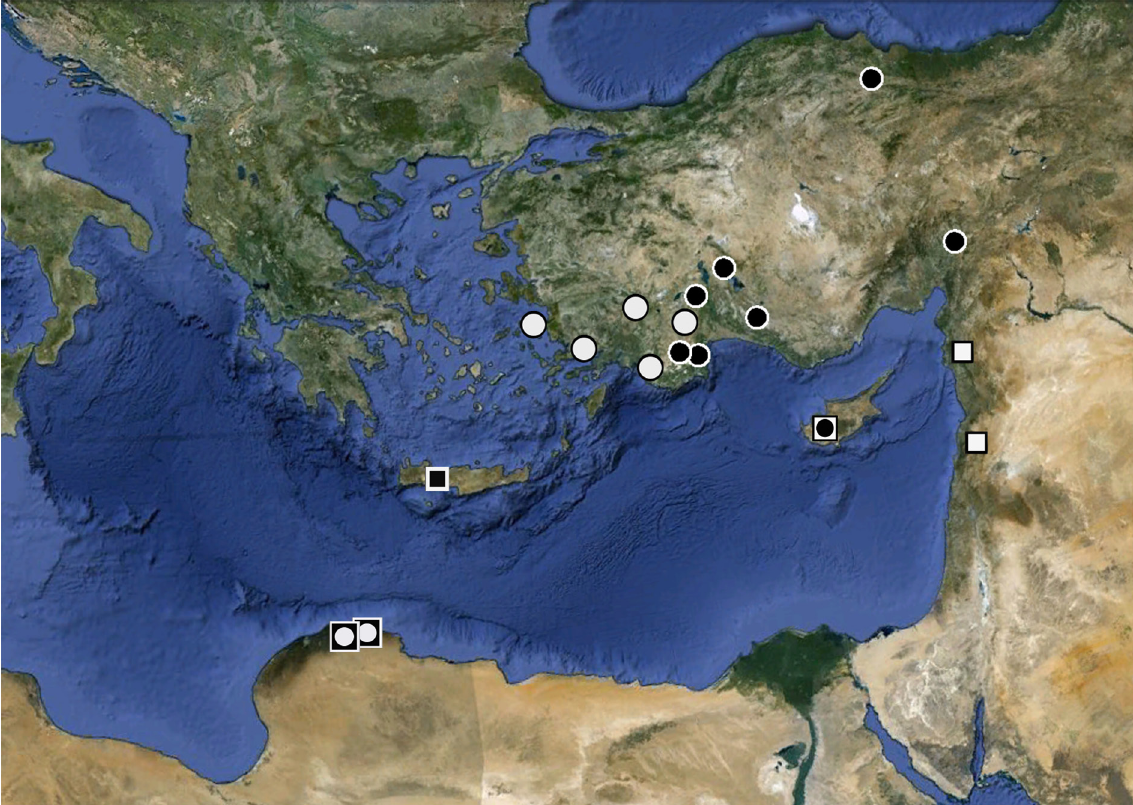
Fig. 4. Distribution areas of Dichorrhinus spp. White circle: Dichorrhinus geiseri sp. nov. Black circle: Dichorrhinus korbi Schilsky, 1911. Black square: D. creticus (Faust, 1889). White square with black circle: D. alziari sp. nov. White square: D. pseudoscythropus Desbrochers, 1875. Black square with white circle: D. freyi Solari, 1840. (Copyright 2012